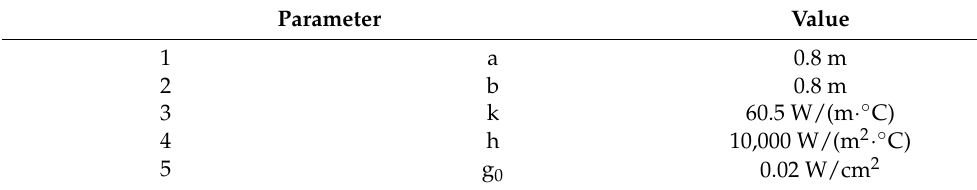
Table 2. Input parameters for steady-state problem of uniform internal heat source.